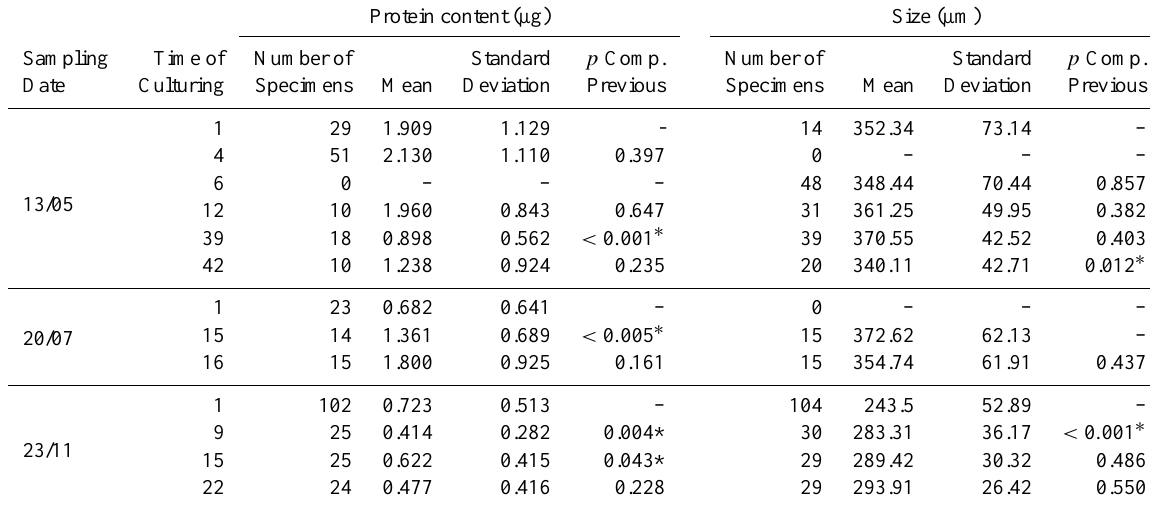
Table 6. Development of protein content and size (minimum diameter) of A. tepida from the three sampling campaigns in May, July, and November 2010, and for all cultivation intervals between 1 and 42 days. Specimens with no measurable proteins were interpreted as dead and were not used for the variance analysis. The probability ( p ) associated with the variance analysis between the subsample of the cultivation time and the previous subsample. Values marked with an asterisk ( ∗ ) are significantly different from the previous subsample.